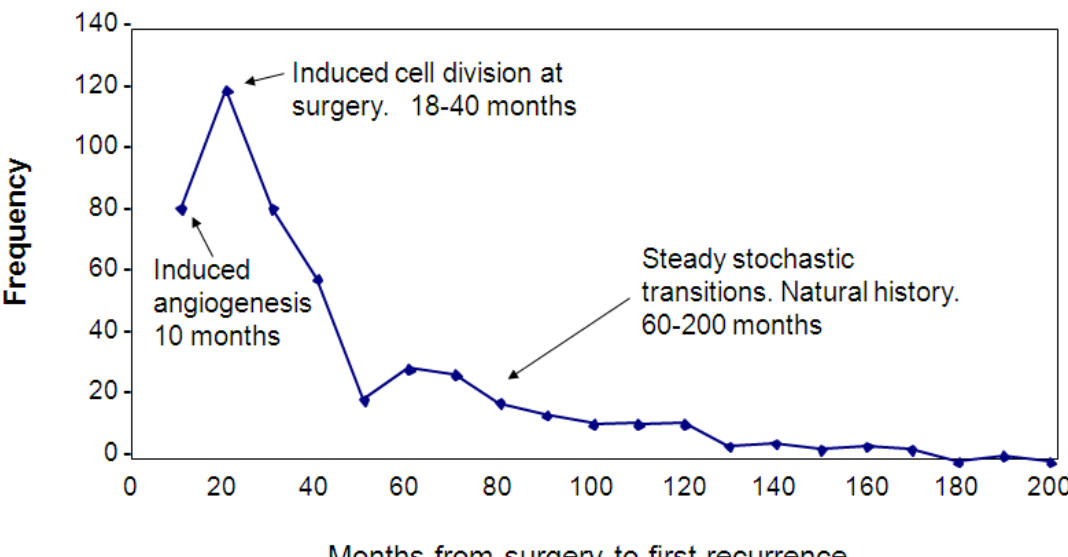
Figure 1. Data from Milan are shown in raw form as number of relapse events in 10- month wide bins. Also indicated are the various modes of relapse that are predicted by the computer